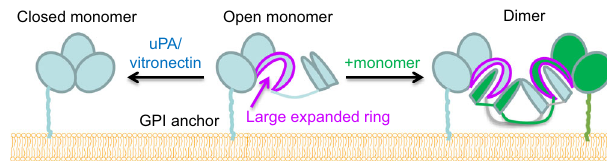
Fig. 6 A schematic model of uPAR dimerization on the cell surface. The unbound uPAR is in dynamic equilibrium between the close (left) and open (middle) conformations. The presence of ligand uPA or vitronectin stabilizes the close conformation (left). A key feature in the open conformation is that uPAR forms a large expanded ring (residues 62 – 92, colored in magenta). When concentrated on the lipid-raft area of the cell surface, the large expanded ring can capture one β -hairpin loop of another uPAR to form a dimer (right panel) or even